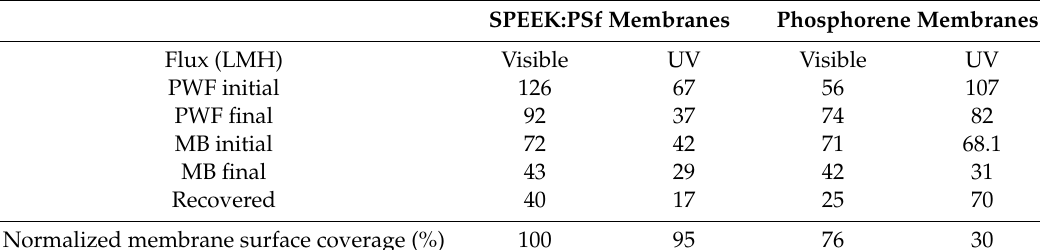
Table 2. Flux values of phosphorene membranes operated under visible and UV light sources. SPEEK:PSf Membranes Phosphorene Membranes Flux (LMH)